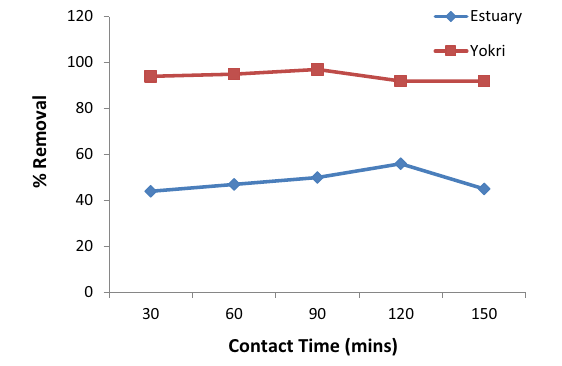
Fig. 3 Effect of contact time on the sorption of crude oils onto